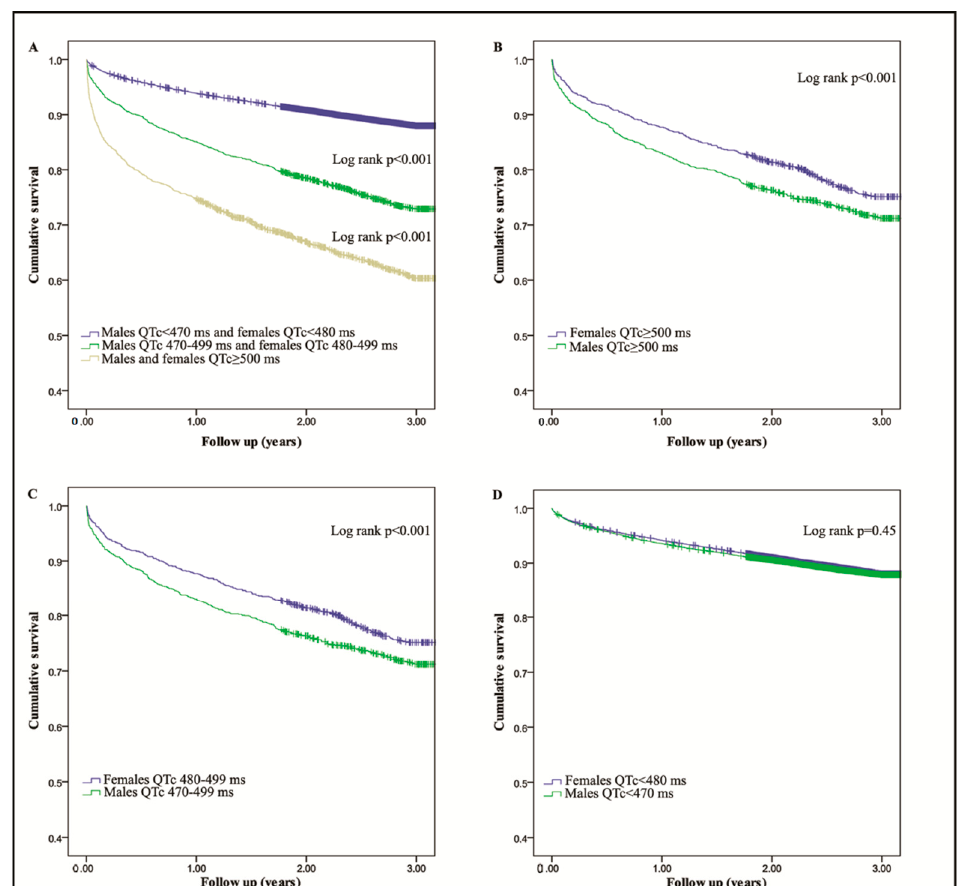
Figure 4. From reference [31]: the panels ( A – D ), illustrate 3-year survival curves for 1531 male and female patients with QTc > 500 ms versus controls, 2099 male and females with 500 > QTc > 470–480, and for 43,893 male and female without QTc prolongation. Reproduced with permission from Oxford University Press.